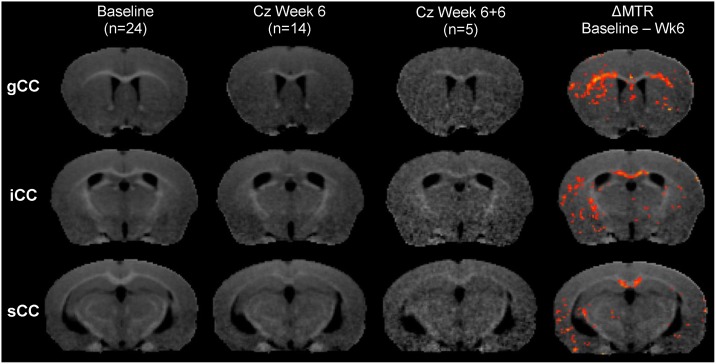
Population averaged Coronal MTR maps.MTR maps at the level of gCC (top row), iCC (middle row), and sCC (bottom row). ΔMTR (p < 0.01) values are overlaid in false color (see Fig 5 for color bar) in the far right column. Note reduced image quality at Cz Week 6+6 due small number of images included in the average (n = 5) compared to Baseline (n = 24) and Cz Week 6 (n = 14).